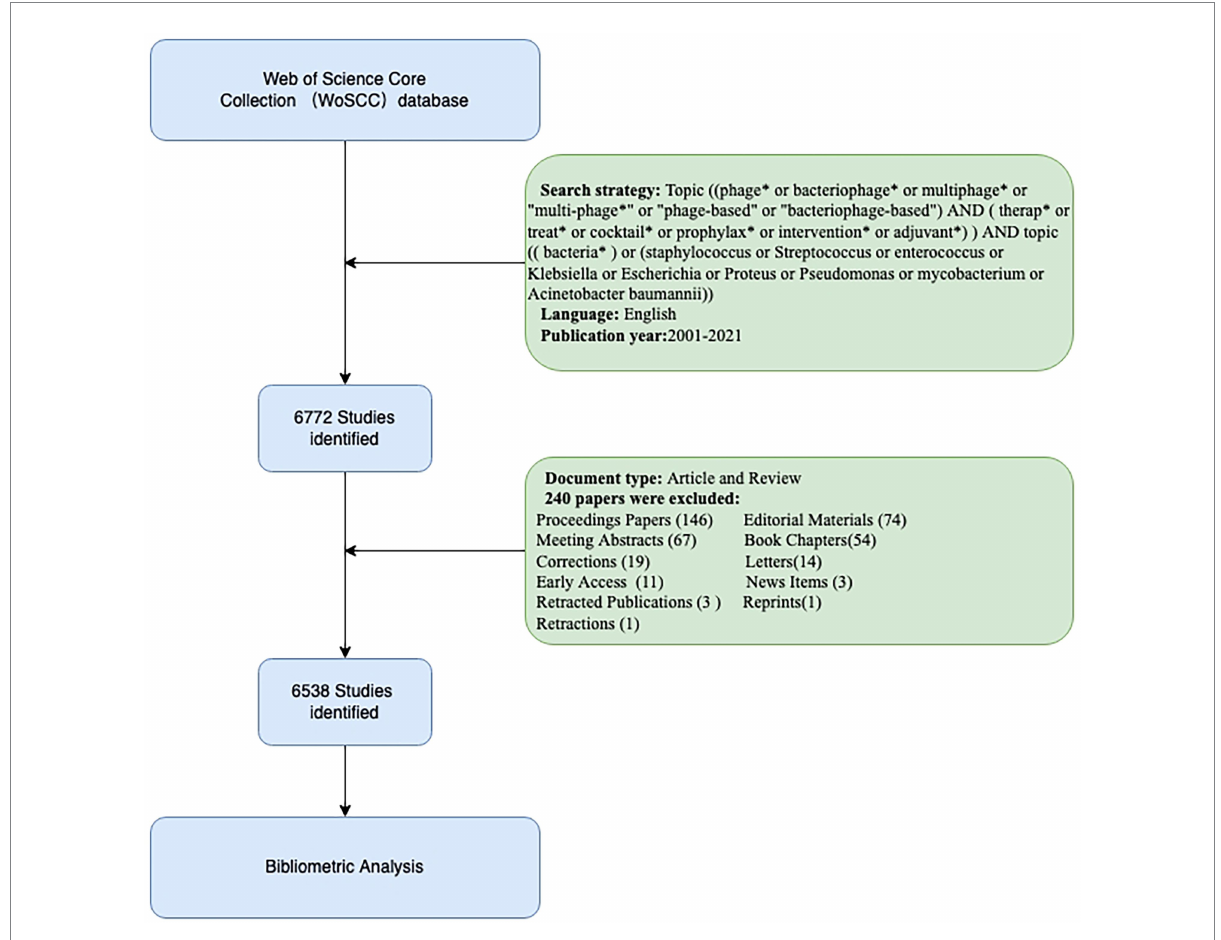
FIGURE 1 Flowchart of the data screening